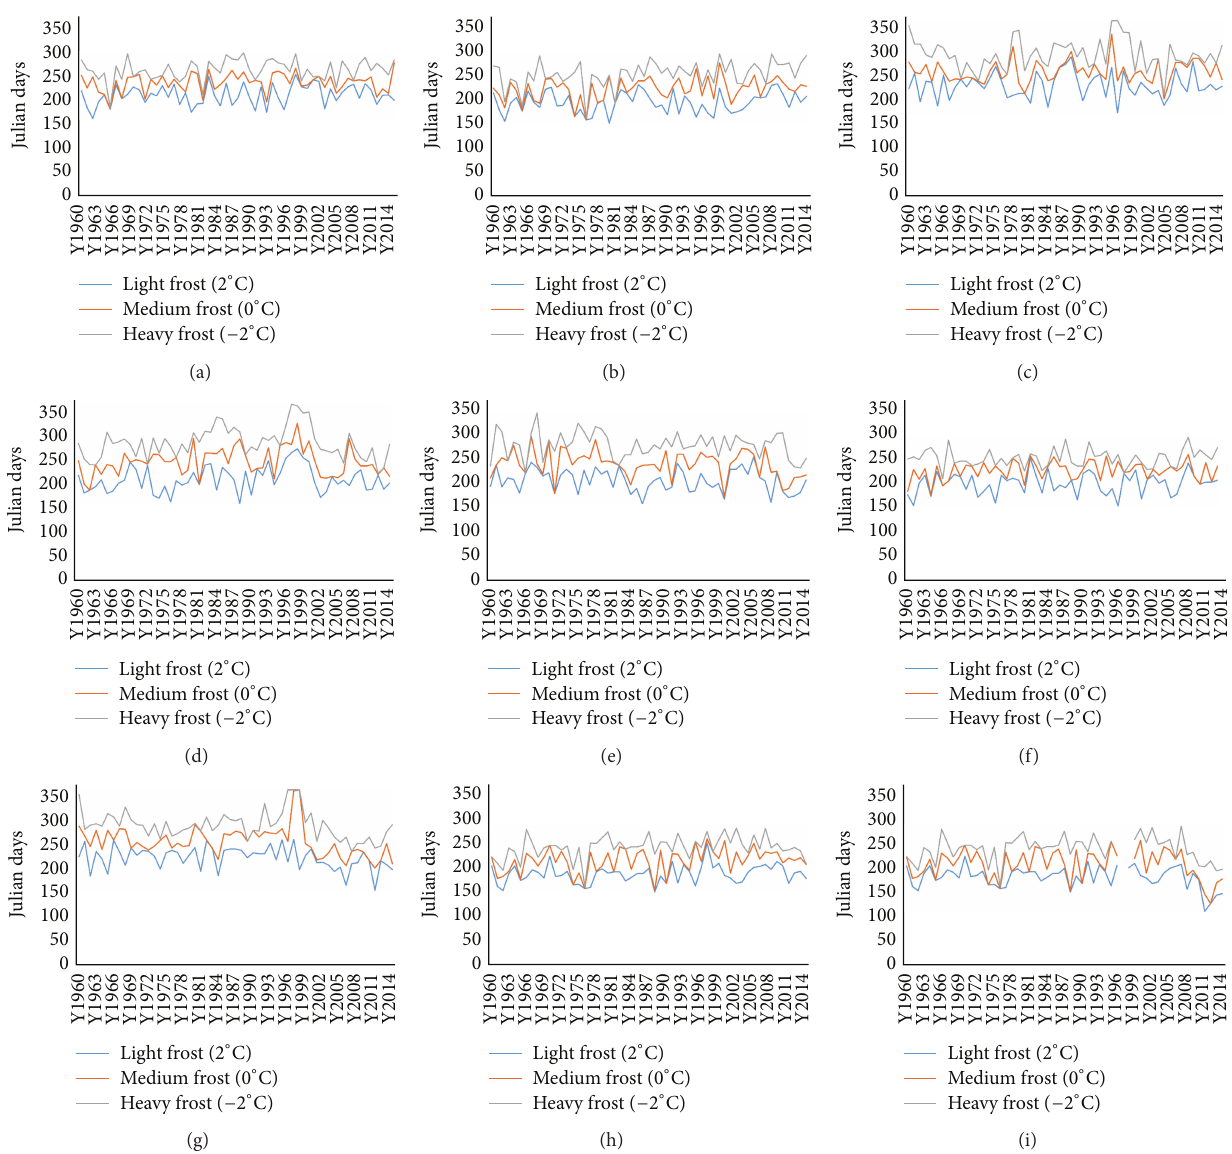
of short frost-free season are mostly over the southeastern parts, close to the escarpments along the border with